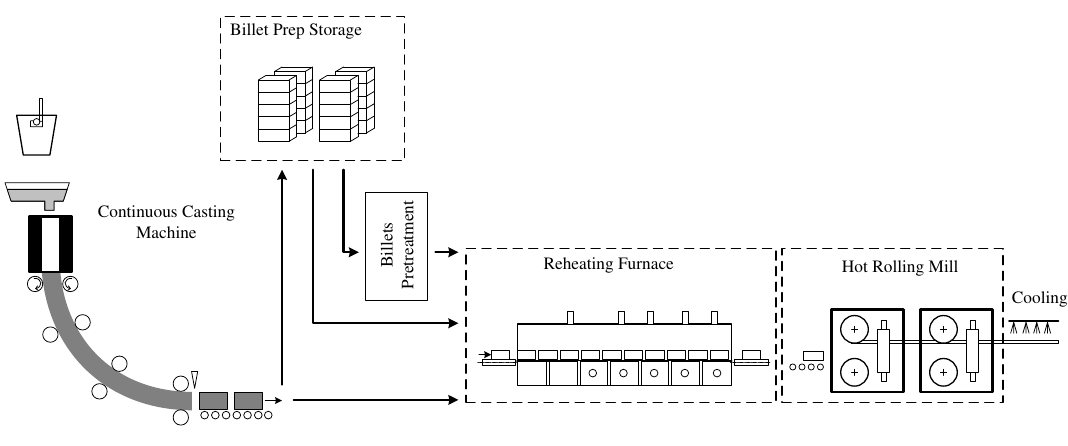
Figure 1. Flat rolling